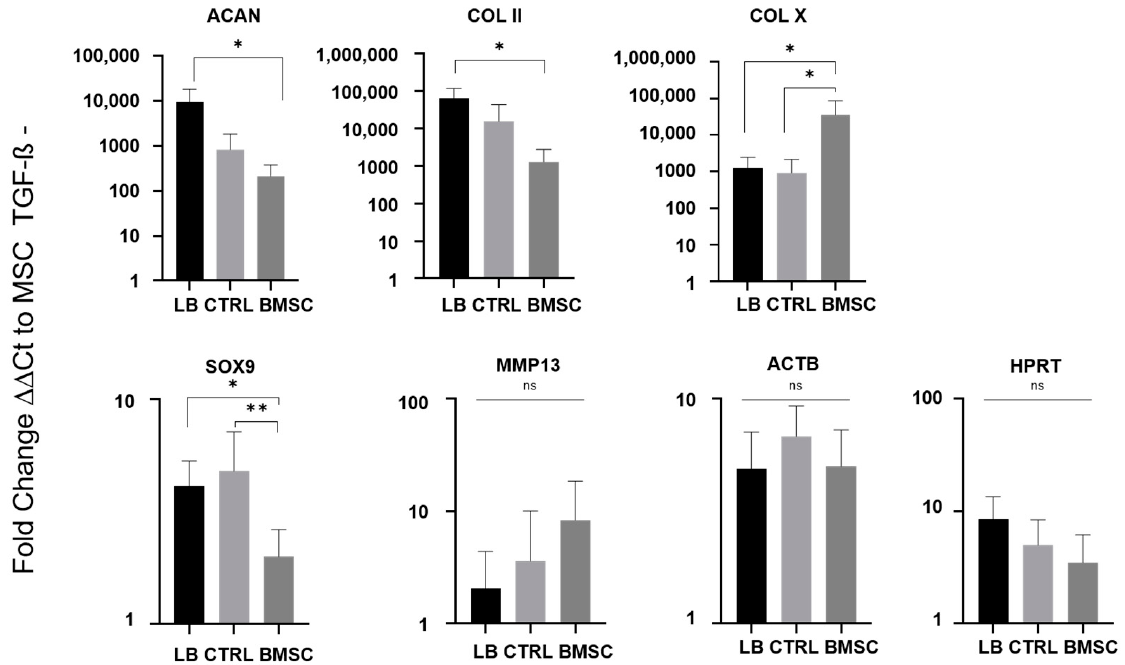
(Figure 5). BMSC cultures without TGF-ß served as reference to define baseline expression values of the undifferentiated cell state. In line the total proteoglycan content, LB-CH exhibited significantly higher aggrecan and collagen II mRNA expression compared to BMSC (ACAN p = 0.0263; COL II p = 0.0104). While no significant difference in mRNA expression were found between LB-CH and CTRL-CH, both groups showed significant higher SOX9 expression compared to BMSCs. In contrast, the mRNA expression of the os- teochondral marker collagen X was significantly higher in BMSCs compared to both LB-CH and CTRL-CH ( p = 0.0108 and p = 0.048). Similarly, the expression of MMP13 was elevated in BMSCs compared to both chondrocyte cultures, but did not reach statistical significance.